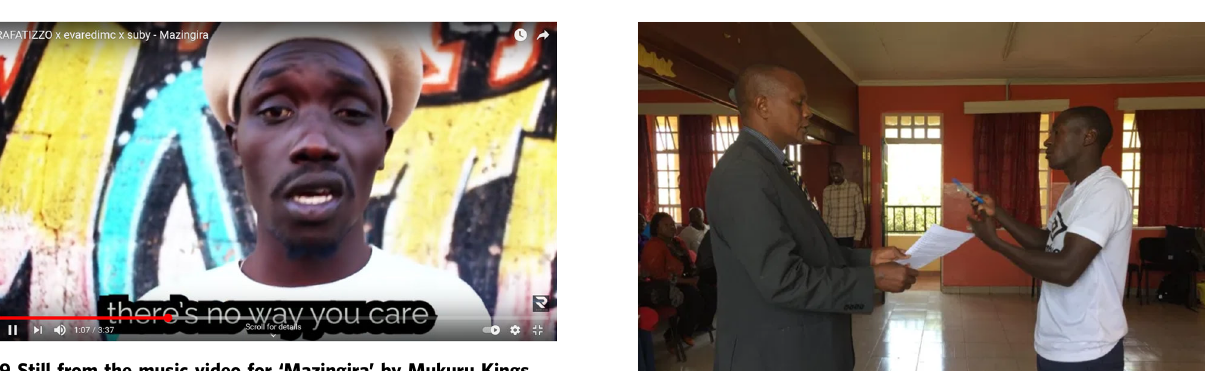
Fig. 9 Still from the music video for ‘ Mazingira ’ by Mukuru Kings, showing image of Rafatizzo. Lyrics and music video can be found in Supplementary Information.